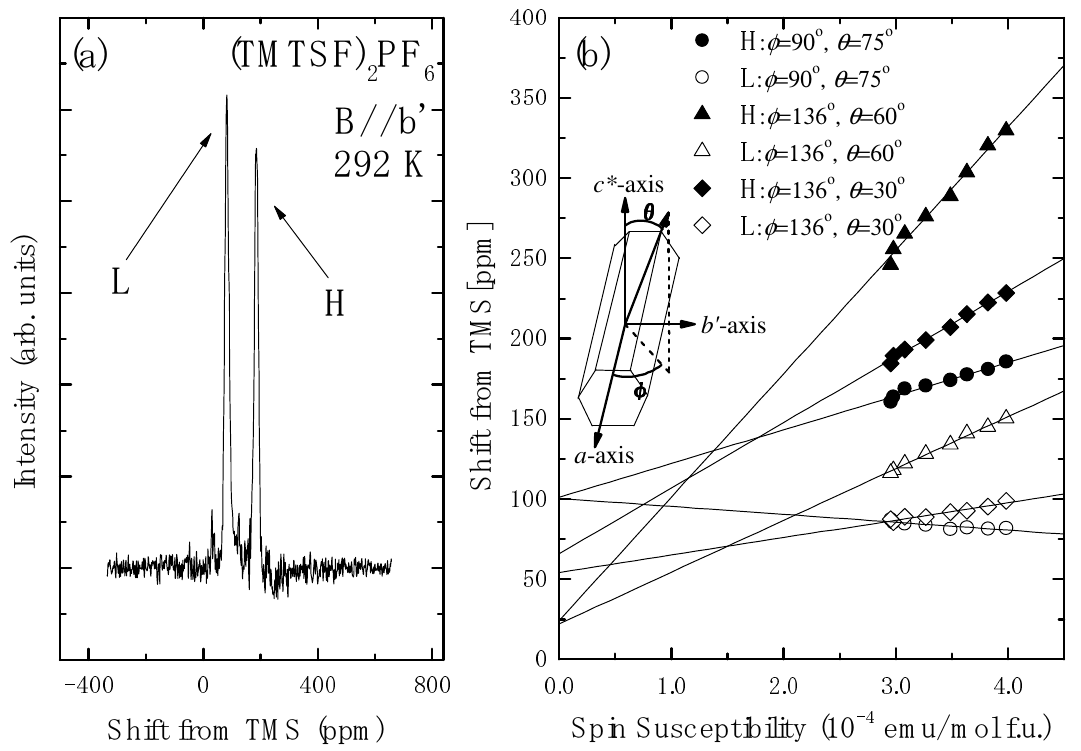
PF at several angles 2 6